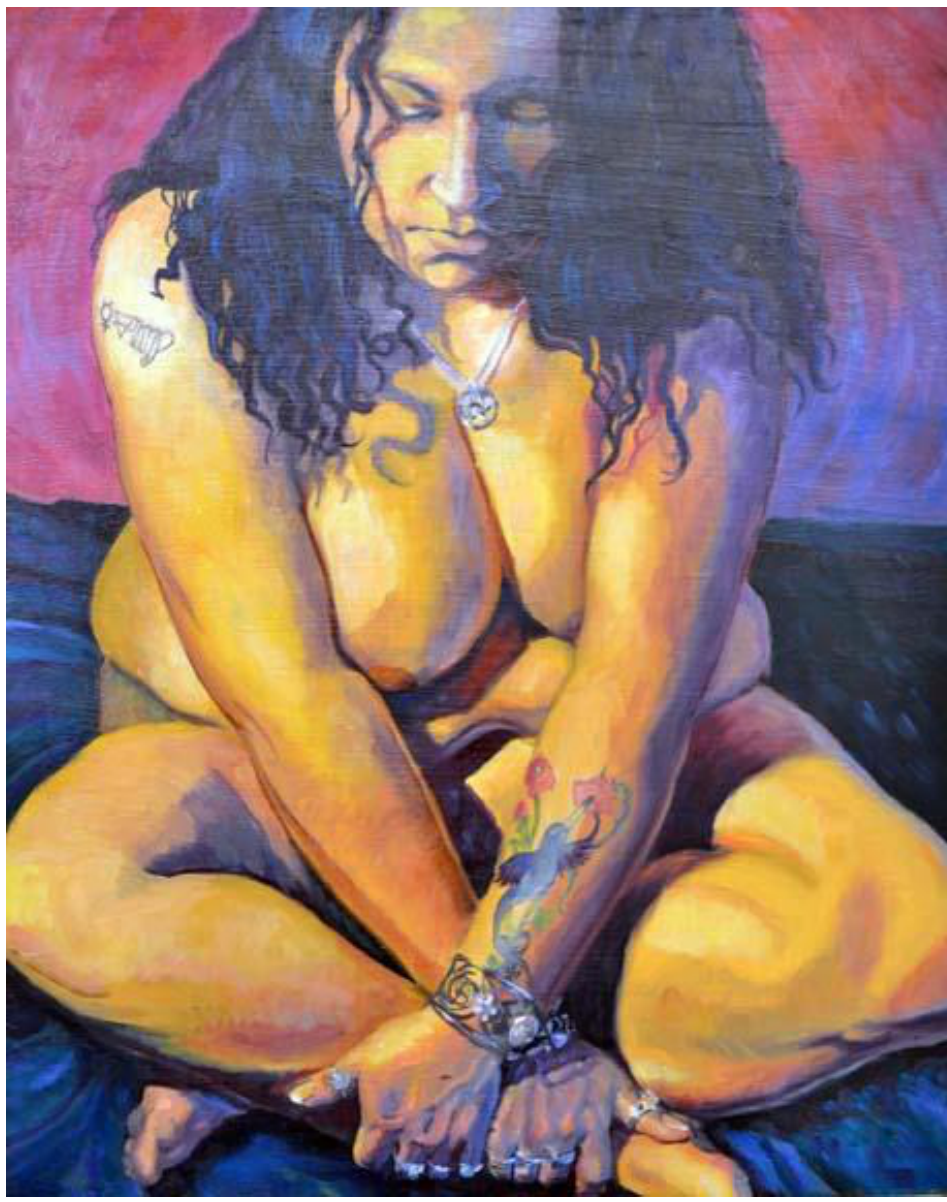
Figure 2 Cecelia Ivy Price, Coming to Confidence II, 2014, Oil on